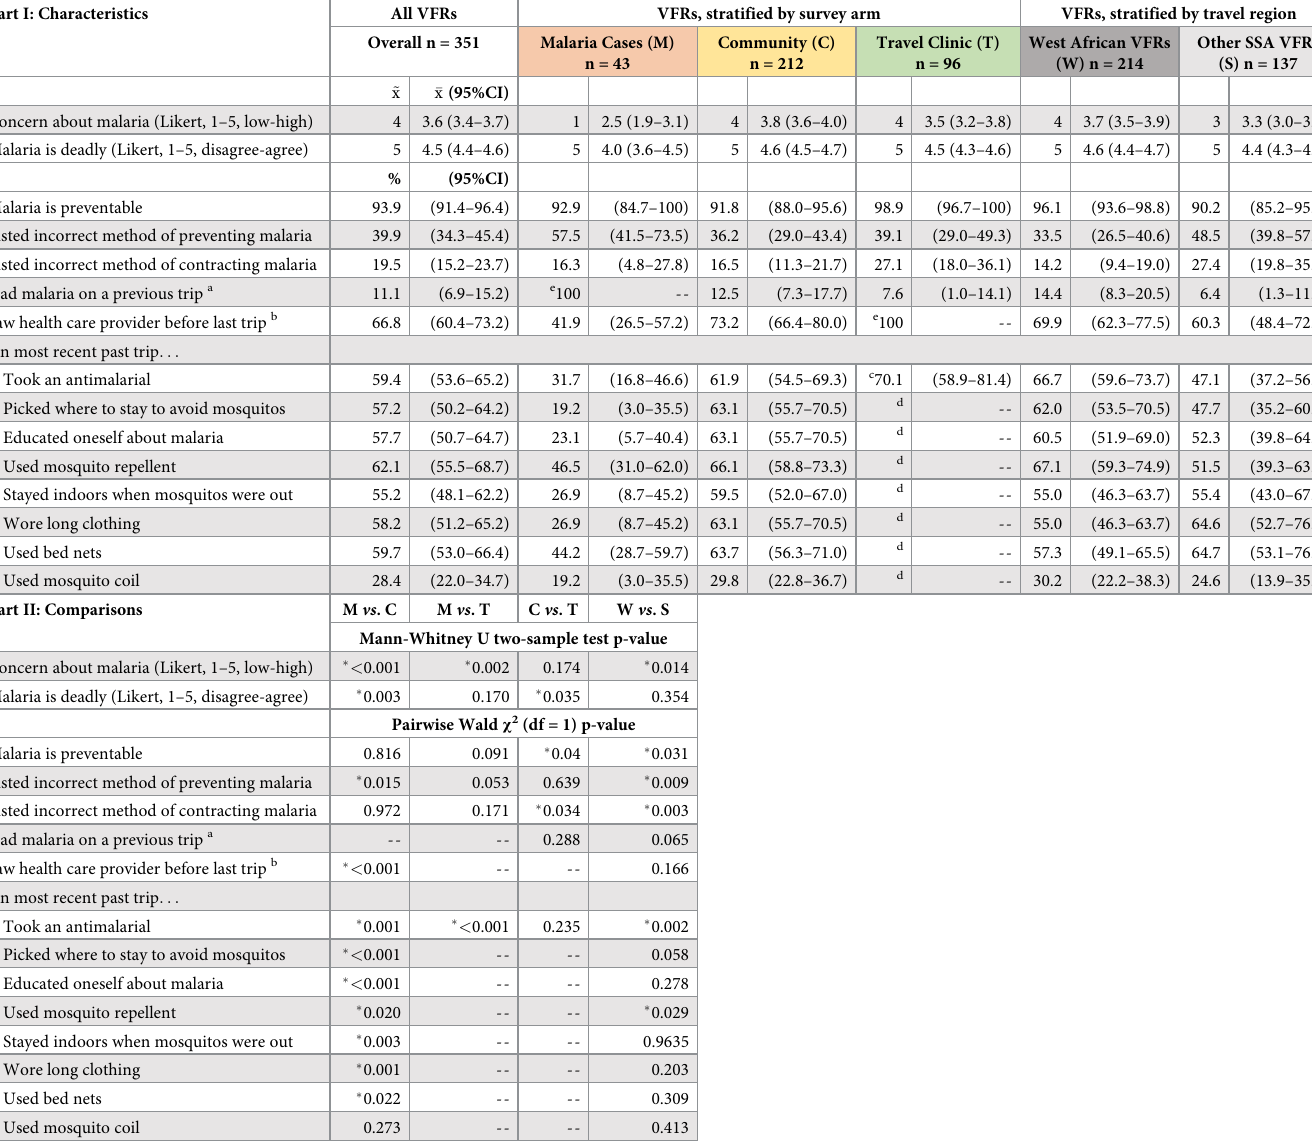
Table 2. A cross-sectional, multi-setting survey of malaria prevention knowledge, attitudes, and practices among US travelers to sub-Saharan Africa: Malaria knowledge, attitudes and practices among travelers visiting friends and relatives, across study arms and regional traveler populations. Part I: